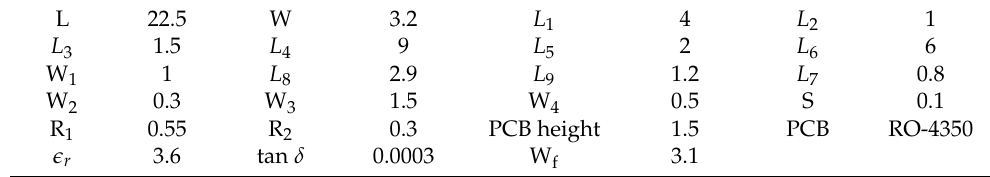
Table 1. Dimensions in millimeter (mm) of the proposed SUWB-BPF with a stub-loaded